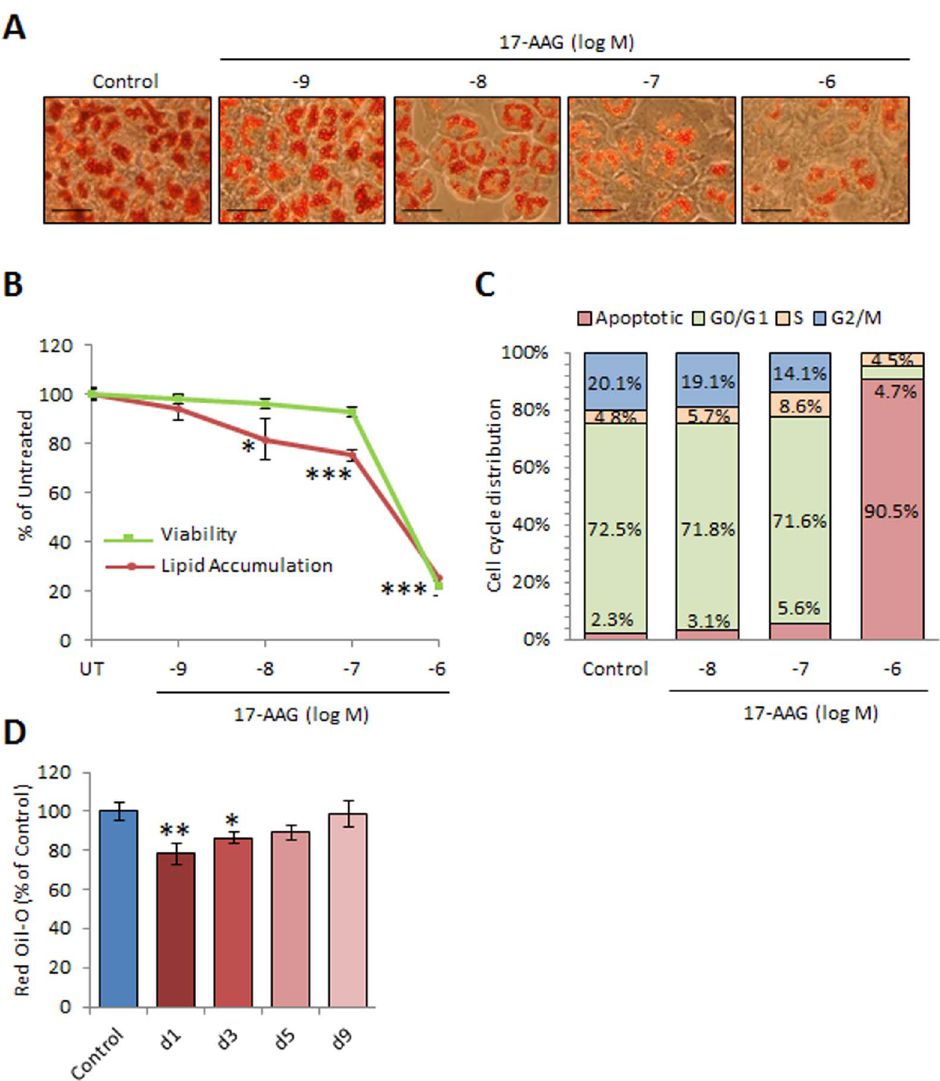
Figure 1. Geldanamycin analogues inhibit lipid accumulation in adipocytes. (A) At confluence, 3T3-L1 preadipocytes were induced to differentiation in presence of an increasing dose of 17-AAG for 9 days. Lipid accumulation was visualized under microscope after Oil-Red-O staining (scale bar, 70 m m) and (B) quantified after extraction of the stained lipid and the absorbance measured at 520 nm. The cell viability was assessed by Trypan blue staining. Data are given as mean 6 SD (n=3), *p , 0.05, ***p , 0.001respect to untreated (C) Differentiating 3T3-L1 cells were cultured for 3 days with or without 17-AAG (100 nM). Cell cycle was determined on FACScan. Given data are representative of 2 independent experiments performed in triplicate. (D) 3T3-L1 preadipocytes were induced to differentiation and treated with 17-AAG (100 nM) at the indicated day. At day 10, lipid accumulation was stained with Oil-Red-O and quantified. Data are given as mean 6 SD (n=3), *p , 0.05, ***p , 0.001